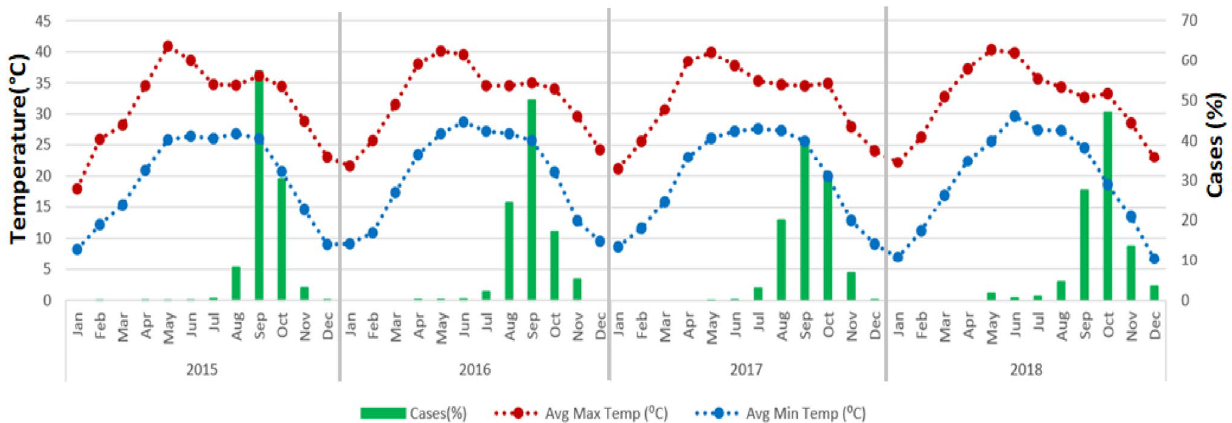
Figure 4. Monthly occurrences of dengue cases and temperature, 2015–18, Delhi,